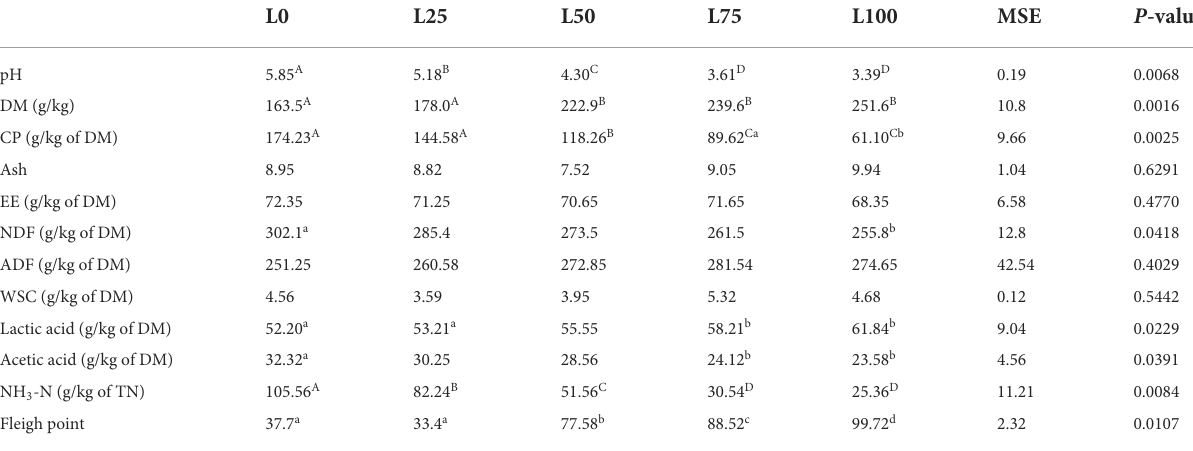
TABLE 2 Chemical composition, volatile fatty acid production, and Fleigh point of different substitution treatments of lucerne with lemon pomace by-product after 60 days of ensiling. L0